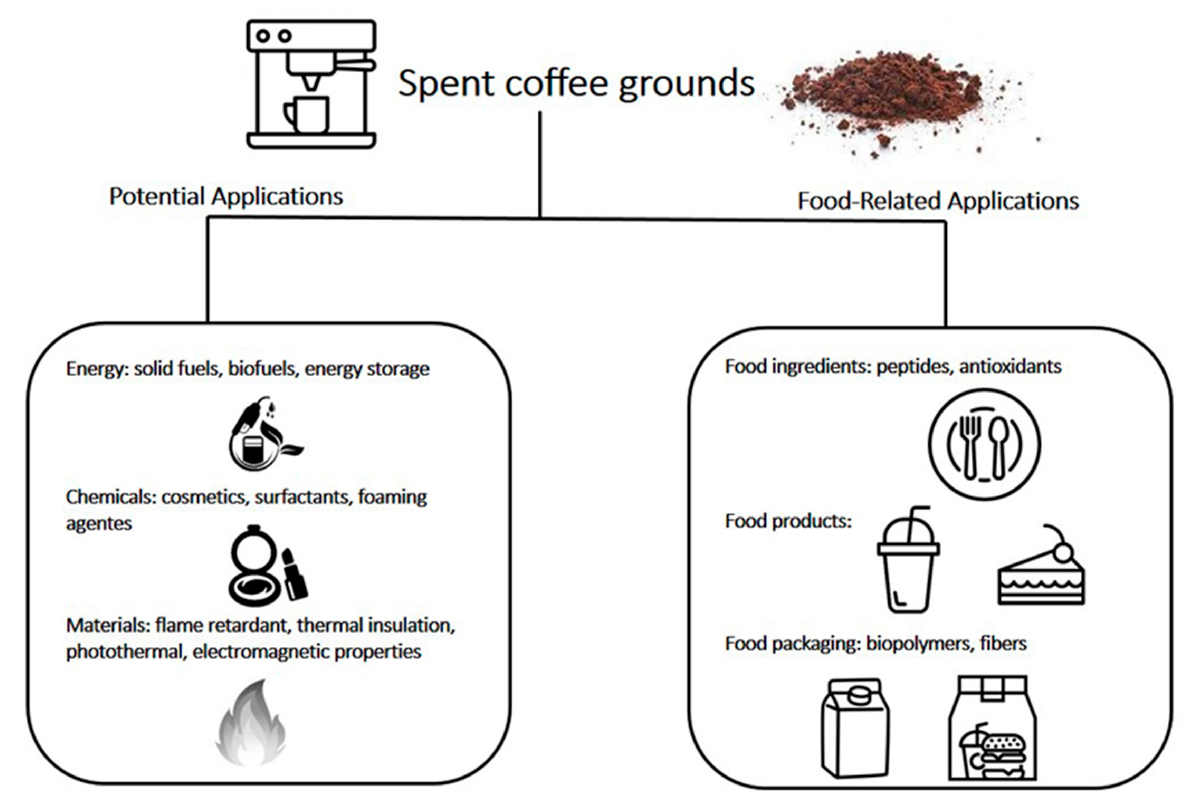
Figure 1. Summarized illustrative overview of potential uses for spent coffee grounds.